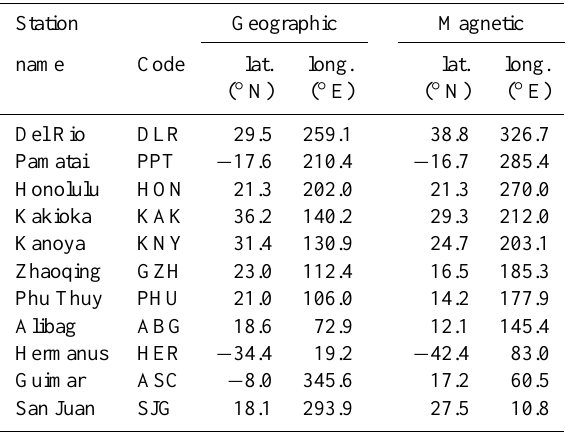
Table 1. List of ground stations and their geographic and magnetic